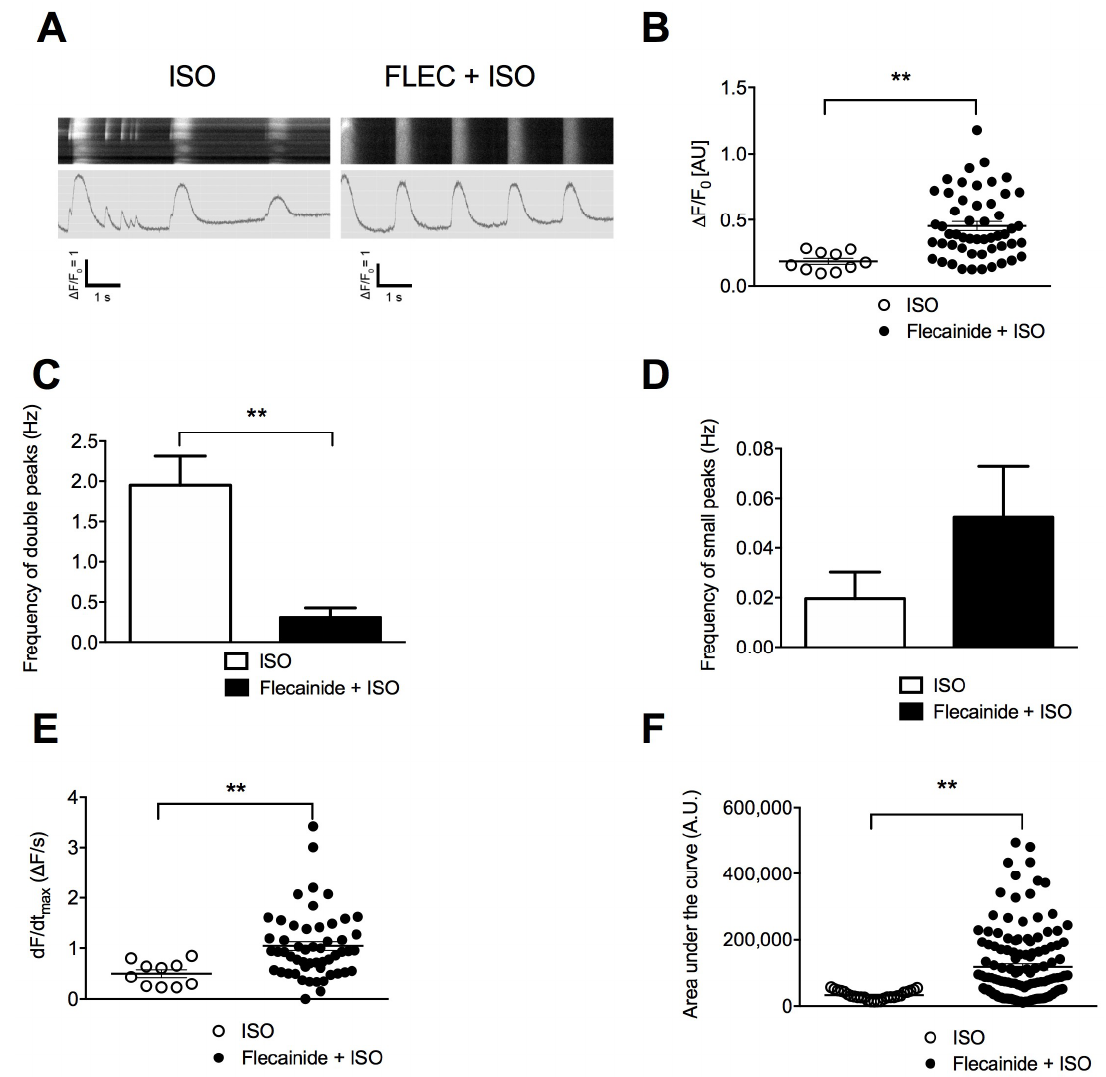
Figure 4. Flecainide (FLEC) partially prevents the aberrant SR Ca 2+ handling in CPVT hiPSC-CMs. ( A ) Display of original line-scan images of Ca 2+ transients and corresponding tracings of CPVT (C1.1) hiPSC-CMs after application of ± 5 µ M flecainide followed by 1 µ M ISO. ( B ) Scatter plots showing maximal Ca 2+ -transient amplitude in CPVT hiPSC-CMs under ISO (white dots) and flecainide + ISO (black dots). ( C ) Bar graphs showing frequency of occurrence of aberrant Ca 2+ -transients in CPVT hiPSC-CMs under ISO and flecainide + ISO. ( D ) Frequency of occurrence of diastolic SR leaky events in CPVT hiPSC-CMs under ISO and flecainide + ISO. ( E ) Rate of RyR2 Ca 2+ release (dF/dt max ) in CPVT hiPSC-CMs under ISO and flecainide + ISO. ( F ) Area under the curve or peak area in CPVT hiPSC-CMs under ISO and flecainide + ISO. The number of experiments varies from 10 to 55 for each scatter plot. Data are presented with mean ± SEM. ** p < 0.01.